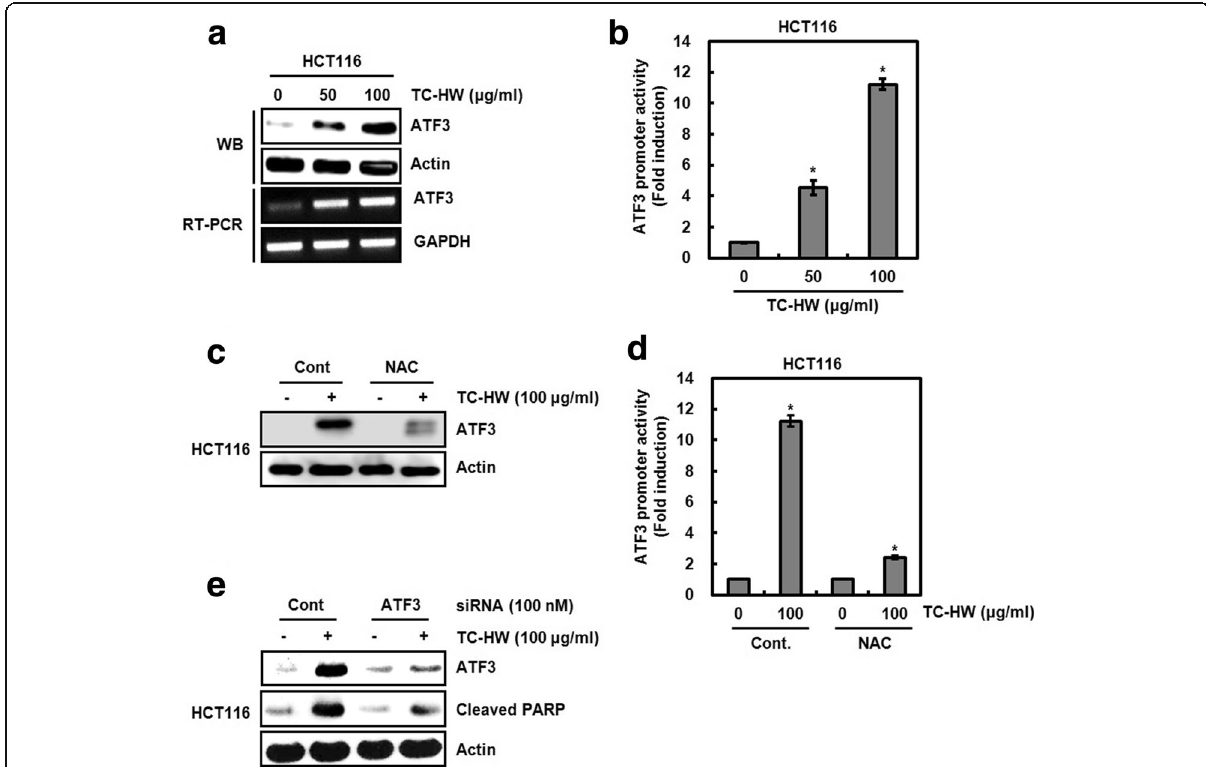
Fig. 6 Contribution of ROS-dependent ATF3 activation to TC-HW-mediated apoptosis. a and b HCT116 and SW480 cells were treated with TC-HW at the indicated concentrations for 24 h. For Western blot analysis, cell lysates were subjected to SDS-PAGE and the Western blot was performed using antibodies against ATF3. Actin was used as internal control for Western blot analysis. For RT-PCR analysis of the gene expression of ATF3, total RNA